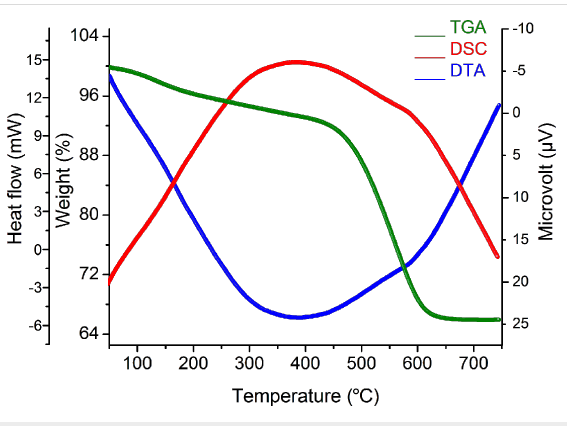
Figure 6: Thermogravimetry (TGA), differential thermal analysis (DTA) and differential scanning calorimetry (DSC) of the as-synthesized Ta 2 O 5 nanoparticles.